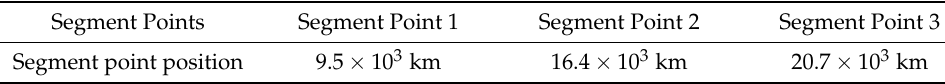
Table 4. Section points of the segmented space elevator